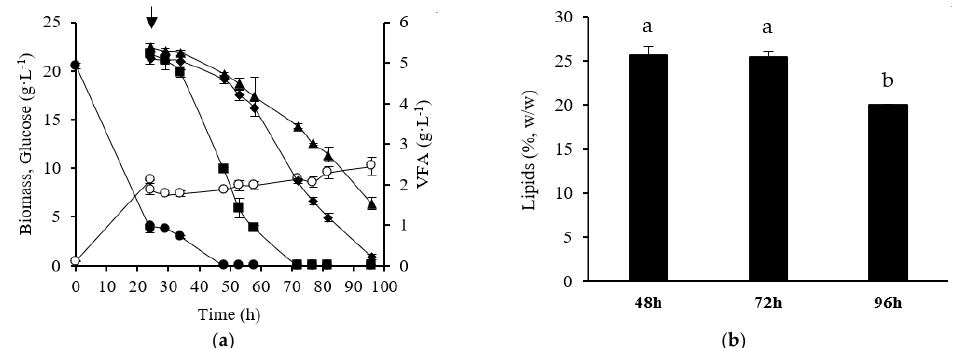
Figure 3. Time course of cellular growth ( ○ ), VFAs ( ■ , acetate; ▲ , propionate; ♦ , butyrate), and glucose ( ● ) concentration obtained in two-stage batch cultures of Y. lipolytica W29 ( a ). After 24 h of growth in glucose, one single pulse of a mixture of 18 g·L − 1 VFAs was added to the culture medium. Lipids content of Y. lipolytica cells obtained at 48 h, 72 h, and 96 h of cultivation ( b ). The error bars represent the standard deviation of two independent replicates. Bars with the same letter do not present statistically significant differences ( p ≥ 0.05). Microbial lipids produced in two-stage batch cultures of Y. lipolytica W29 (growth phase in glucose followed by the addition of 18 g·L − 1 VFAs) were mainly composed of oleic acid (54% ± 1%), followed by linoleic (15.1% ± 0.2%), palmitic (11.9% ± 0.4%), stearic (7.7% ± 1.0%), and palmitoleic (5.5% ± 0.2%) acids. Due to the presence of propionate in